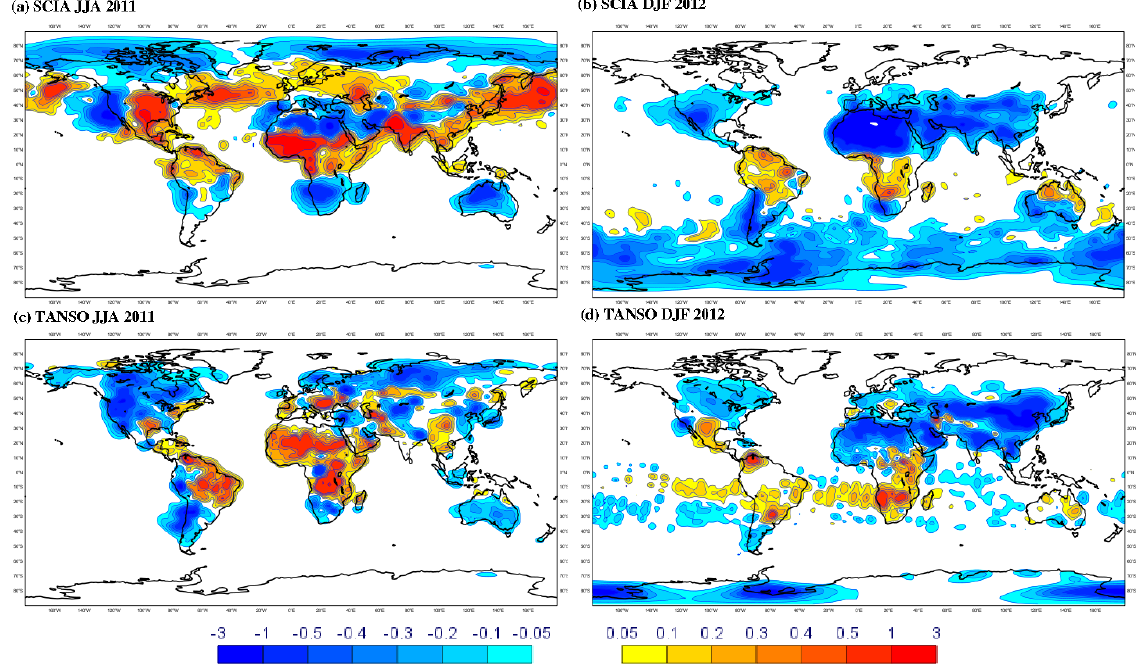
Figure 7. Seasonal average of the increment in terms of CH 4 total column, for JJA 2011 (left) and DJF 2011/2012 (right) in ppb per 12h. Fig. 7. Seasonal average of the increment in terms of CH From top to bottom: SCIA analysis and TANSO top to bottom: SCIA analysis and TANSO analysis.